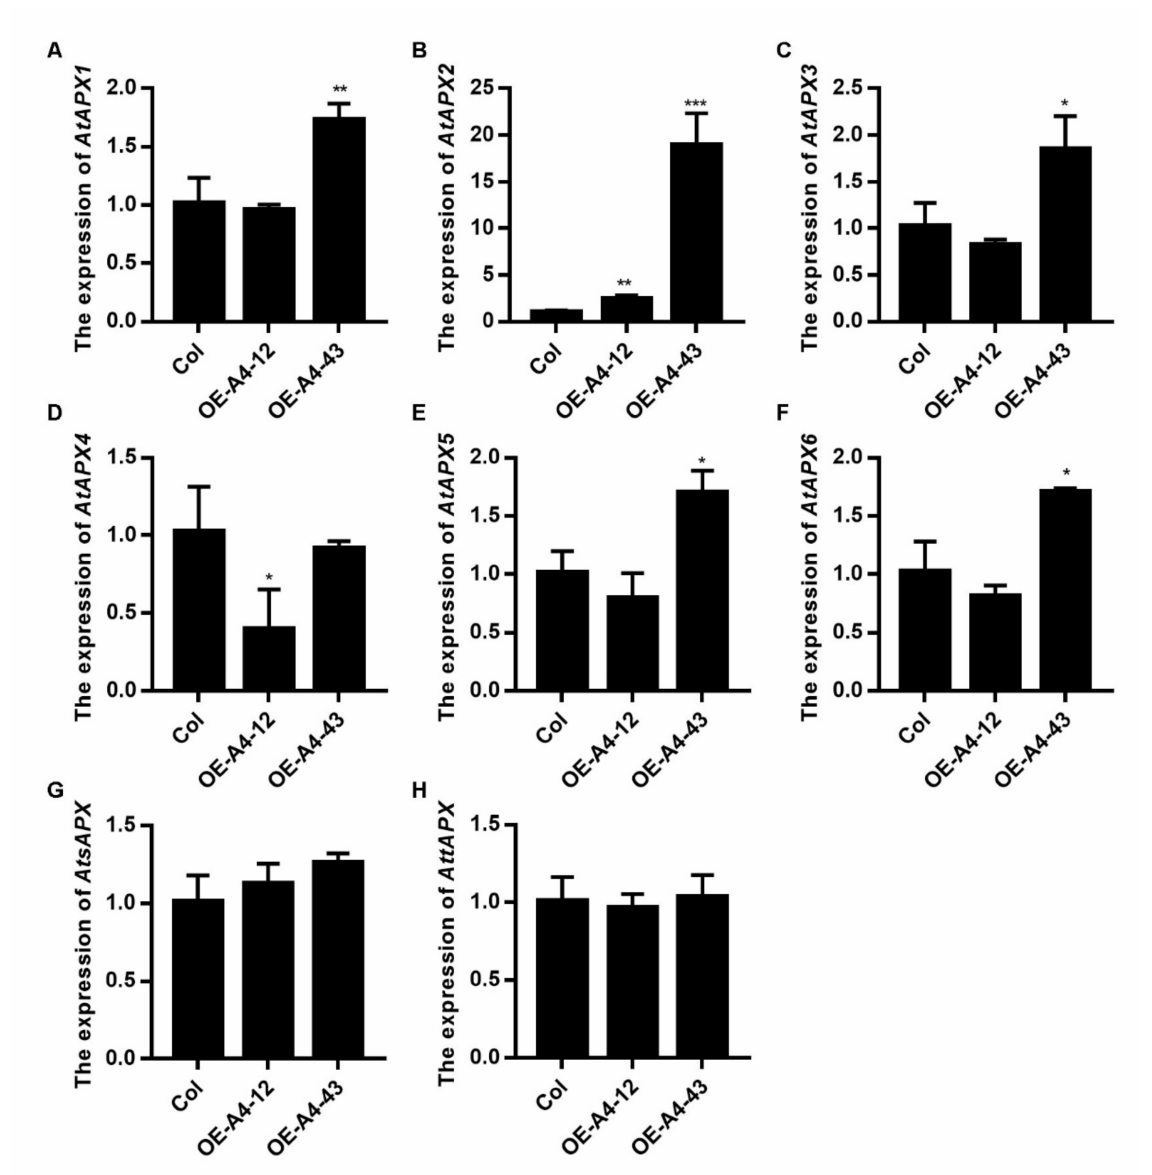
Figure 9. Expression of AtAPXs was examined in LlHsfA4 transgenic plants. ( A – H ) show the Expression levels of 8 AtAPXs . The mRNA level of AtAPXs was detected in wild-type (Col) and transgenic lines using qRT-PCR. The expression values of these genes in Col were set as 1 for comparison and AtACTIN2 was used as an internal standard. 10-day-old seedlings were collected for RNA extraction. Three independent experiments were performed, each with three technical replicates, showing one experiment result. t -test analysis of variance was employed to identify treatment means that differed statistically. Samples with different letters are significantly different: * p < 0.05, ** p < 0.01, *** p < 0.001, Unmarked means